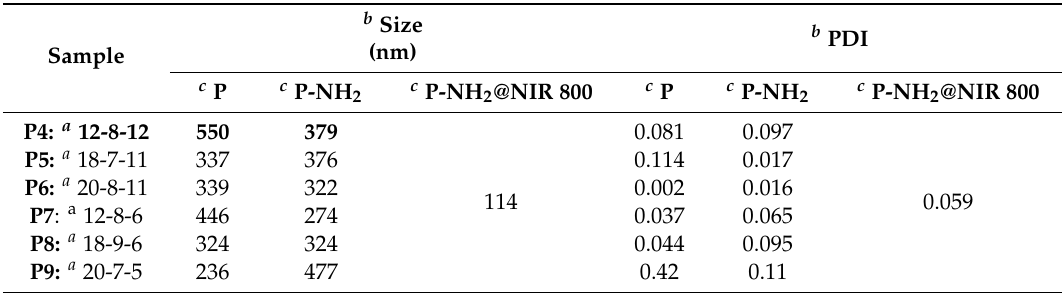
Table 2. Results of size and size PDI from the self-assembly of PBnMA- b -P(BAPMA- co -PEGMA), PBnMA- b -P(APMA- co -PEGMA), and PBnMA- b -P(APMA- co -PEGMA)@NIR 800